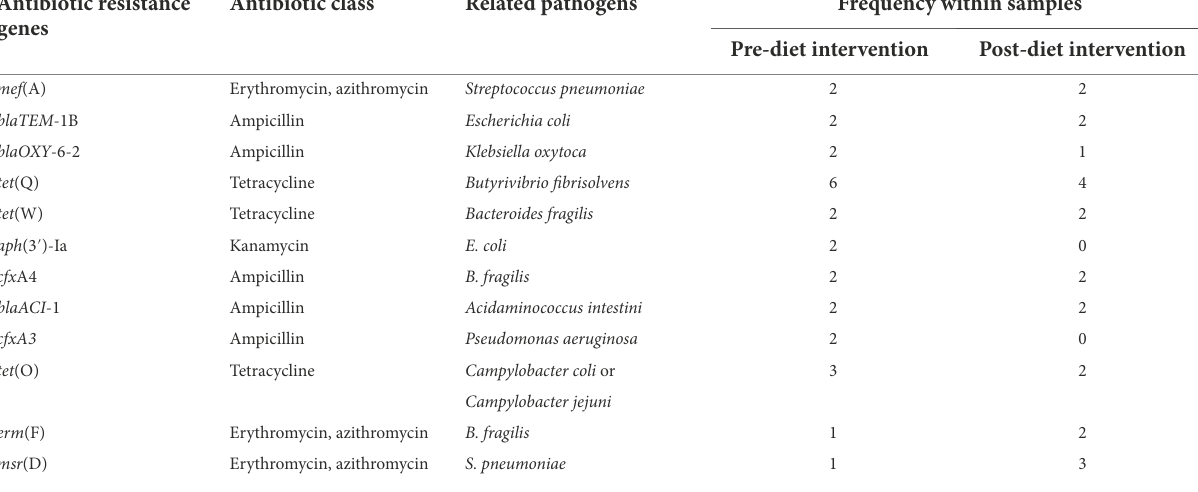
TABLE 6 Most commonly detected antibiotic resistance genes and their associated antibiotic class in pre-and post-dietary intervention infant faecal samples. Antibiotic resistance